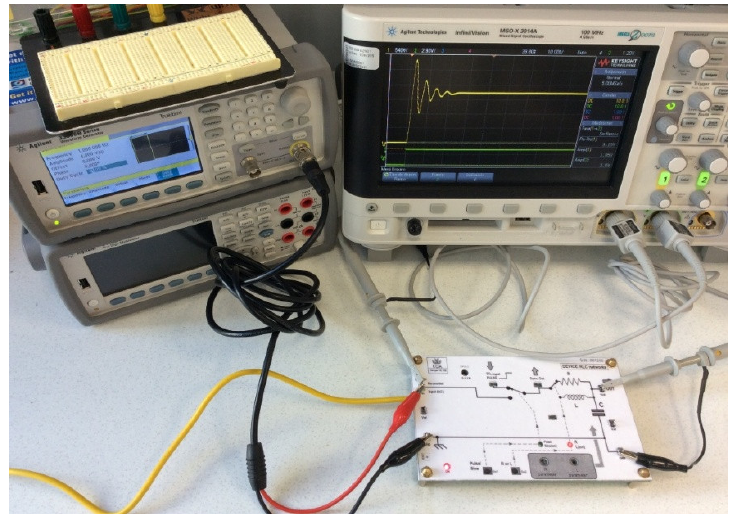
Figure 11. Second-order response implementing (implementing Equation (6)). Table 2. FIR algorithms execution times according to the type of platform.